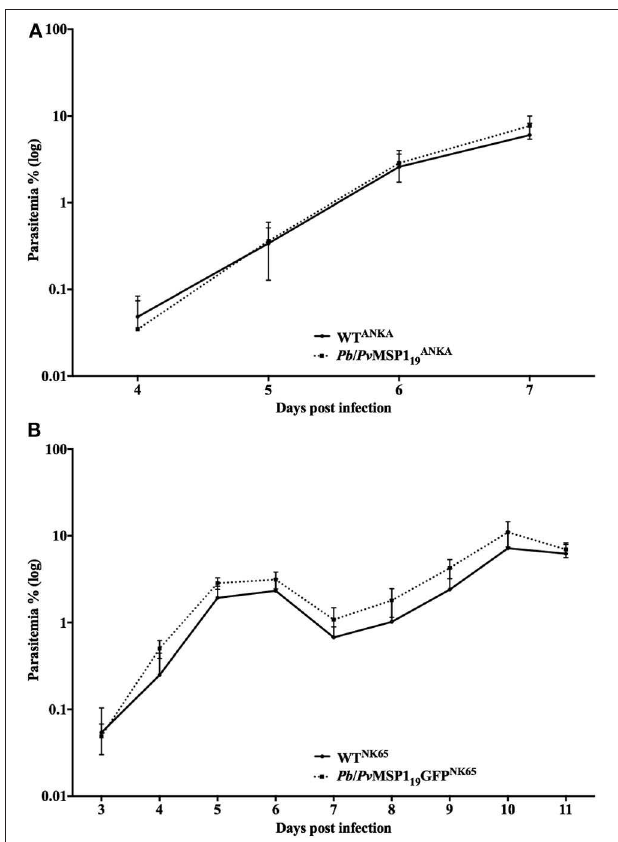
FIGURE 3 | In vivo multiplication of the mutant Pb/Pv MSP1 lines is similar to that of WT parasites. (A) C57BL/6 mice ( n = 5) were infected i.v. with 10 3 red blood cells infected with P. berghei ANKA WT (WT ANKA ) or with the hybrid line Pb/Pv MSP1 ANKA 19 . Parasitemia was followed daily by blood smears. (B) BALB/c mice ( n = 5) were infected i.v. with 10 3 red blood cells infected with P. berghei NK65 WT (WT NK65 ) or with the hybrid line Pb/Pv MSP1 19 GFP NK65 . Parasitemia was followed daily by blood